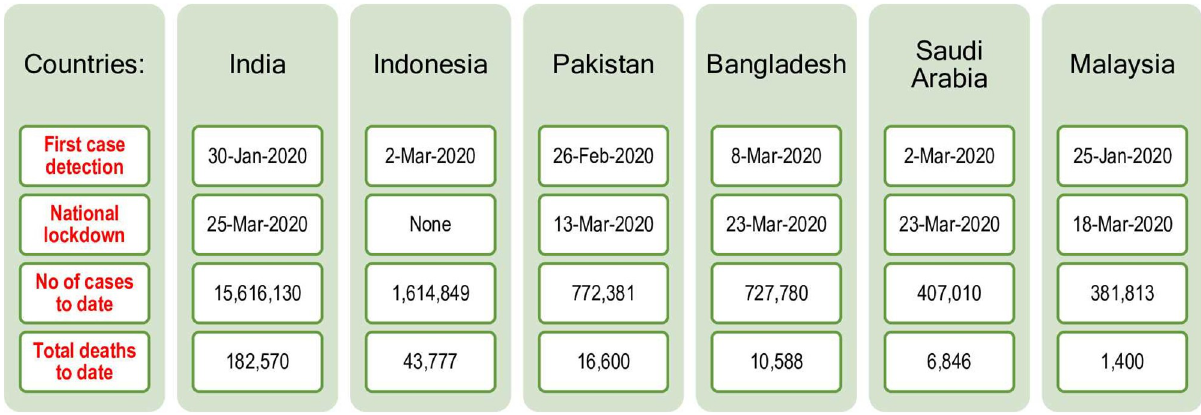
Fig 1. COVID-19 case detection, lockdown, number of cases and